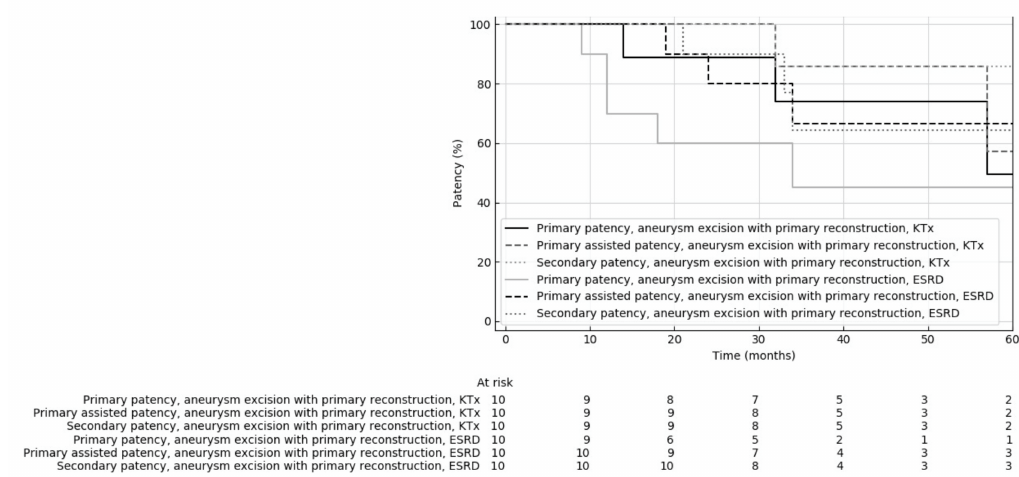
Figure 1. Comparison of primary, primary assisted and secondary patency rates of dialysis fistulas reconstructed by fistula aneurysm combined with primary reconstruction in kidney transplant patients (KTx) and dialyzed patients with end-stage renal insufficiency